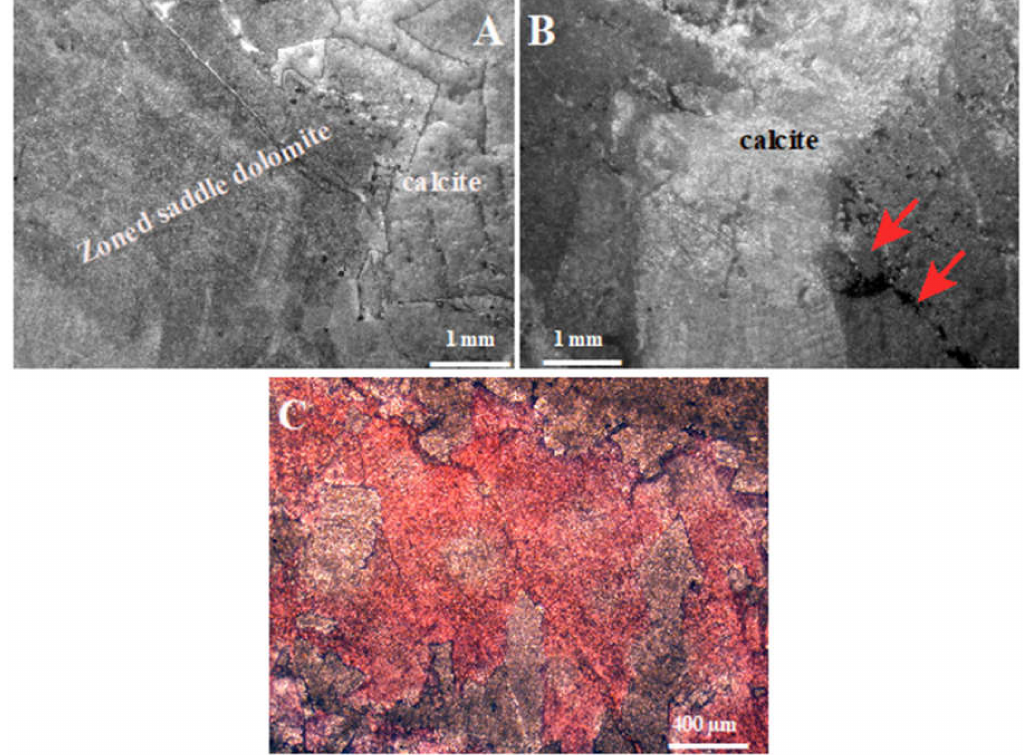
Figure 5. ( A ) The former saddle dolomite SD3 T leaving traces along the core and cortex of zoned SD4 T , reveals that SD4 T was formed under di ff erent diagenetic conditions. C1 T filled the remaining secondary pores, and postdating the latter saddle dolomite. ( B , C ) Millimeter-sized fracture-filling Fe-poor, late stage calcite cement (C1 T ), postdating late stylolite